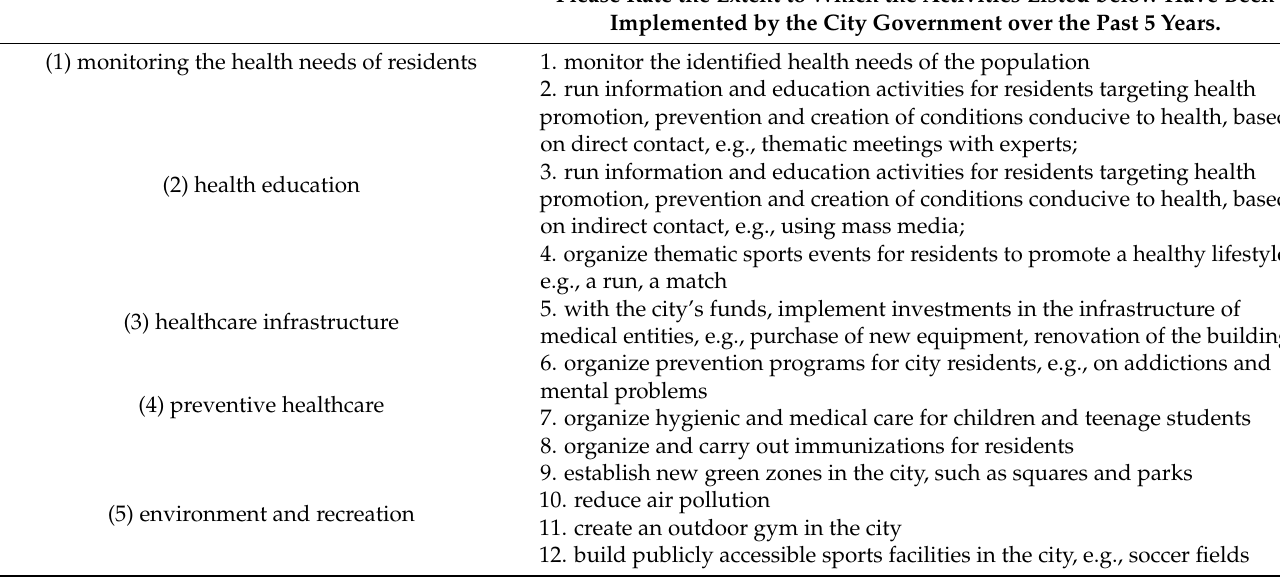
Please Rate the Extent to Which the Activities Listed below Have Been Implemented by the City Government over the Past 5